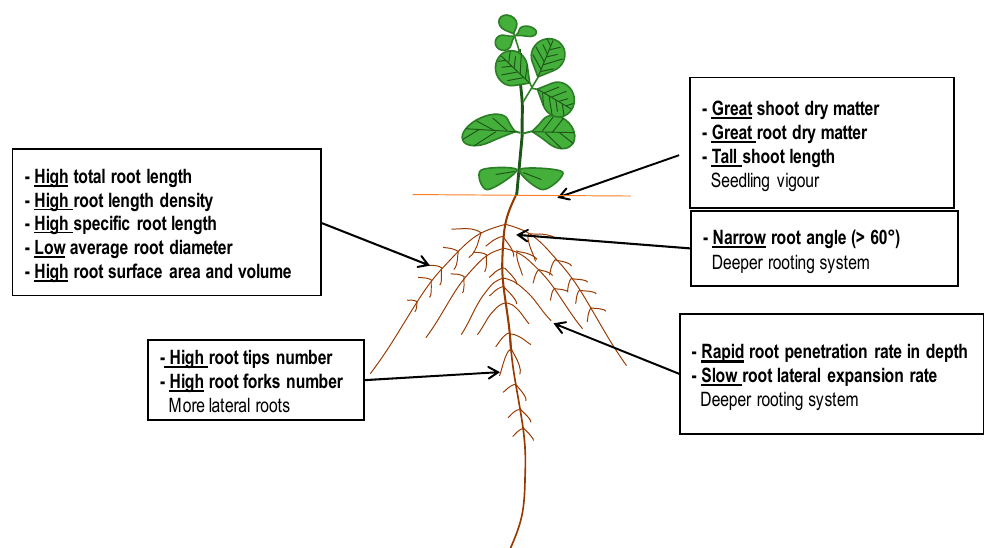
Figure 6. Design of a potential ideotype of soybean cultivar for drought avoidance during early growth.